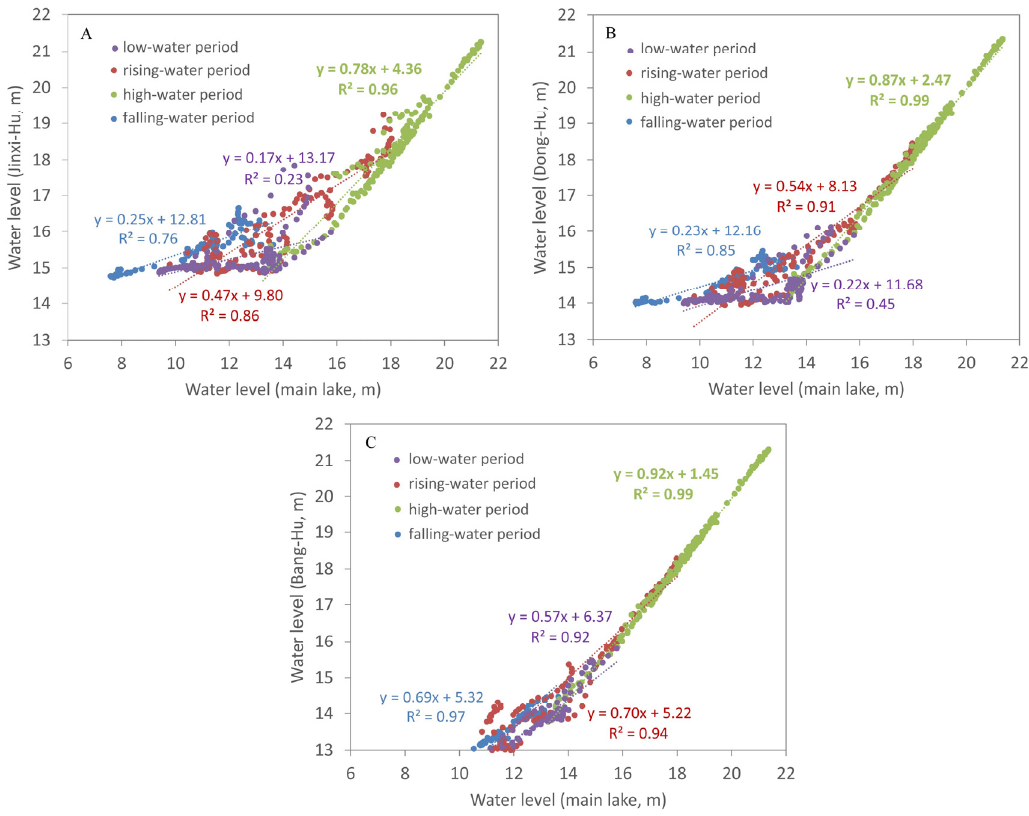
Figure 4. Water levels of ( A ) Jinxi-Hu, ( B ) Dong-Hu and ( C ) Bang-Hu vs main lake body, with associated R 2 indicated during different water regime periods. Lines represent results of linear regression analysis.